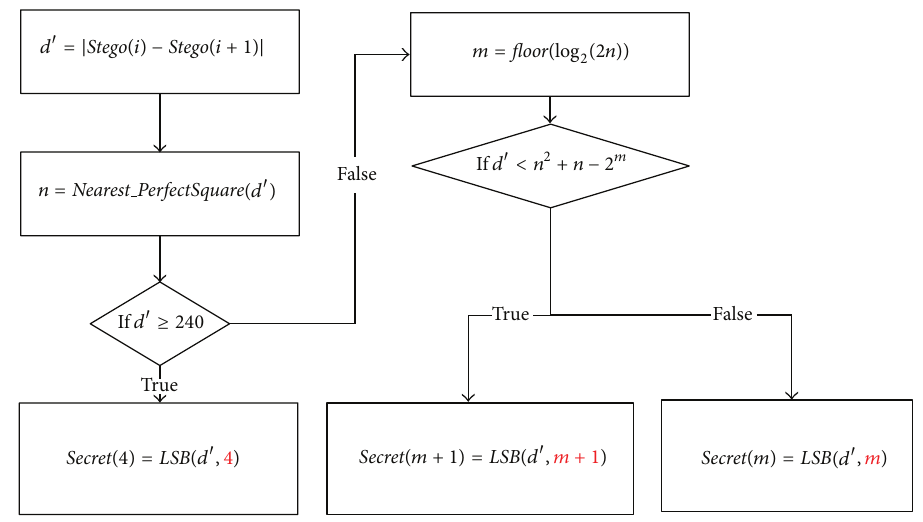
Figure 3: The extraction